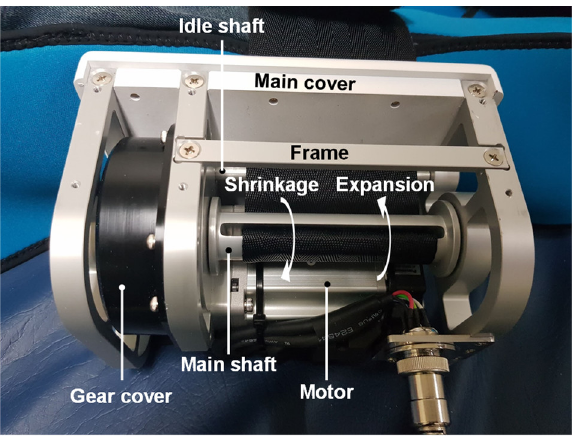
Figure 4. Detailed view of the internal structure of the medical electric leg compression machine.